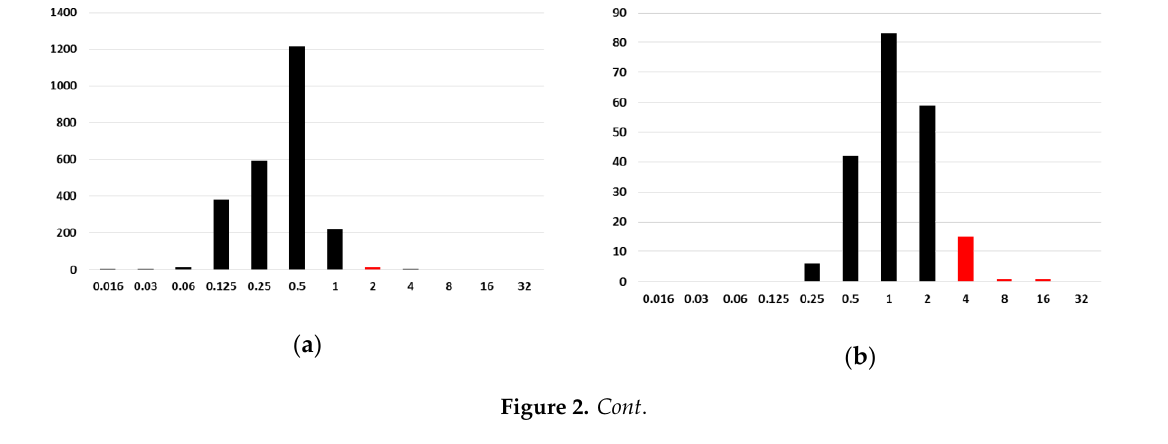
Table 1. ECOFFs and clinical breakpoints for amphotericin B against Aspergillus spp. according to the